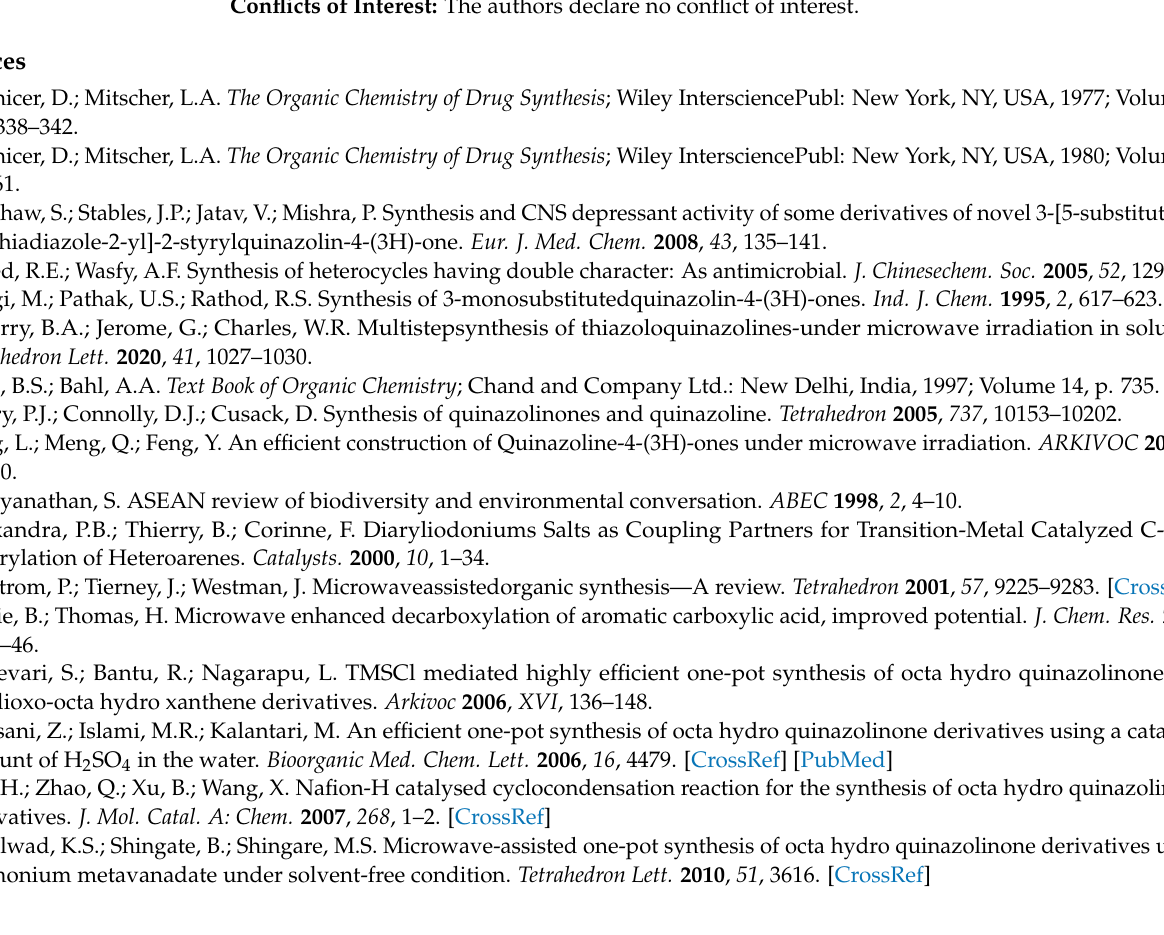
Figure S4. Mass spectrum of